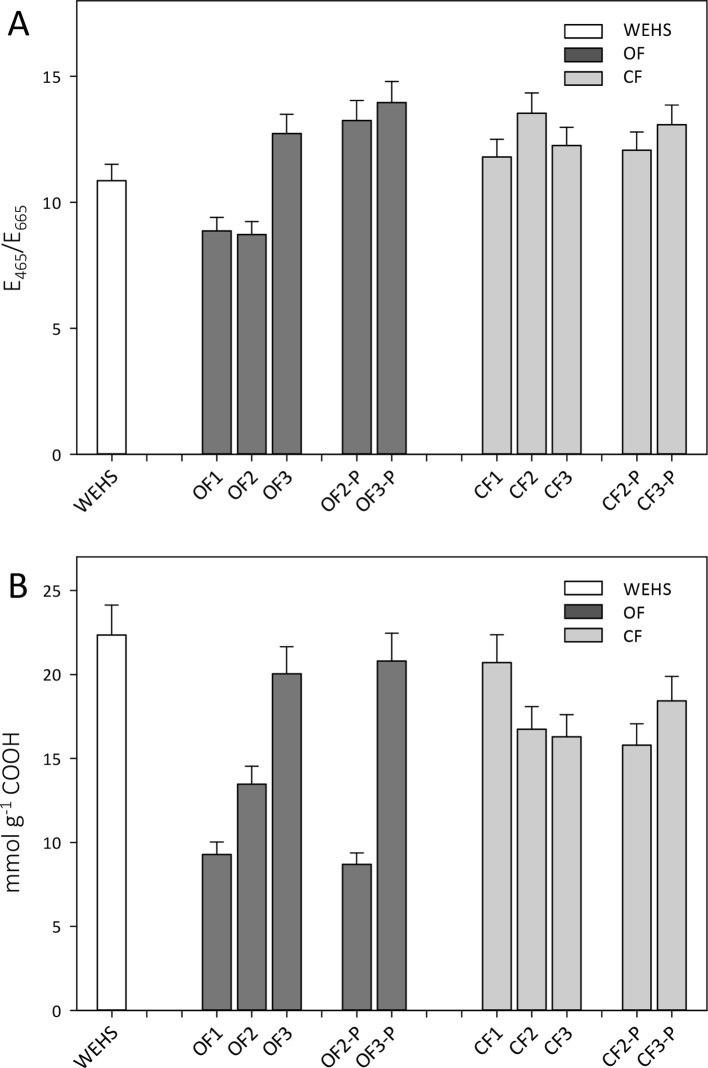
E465/E665 ratios of organic farming (OF) and conventional farming (CF) fractions (A) and density of carboxylic groups in dissolved humic substances (DHS) obtained by titration with NaOH 0.1 M (B). White bar refers to water-extractable humic substances (WEHS); dark gray bars refer to DHS isolated from OF soils; light gray bars refer to DHS isolated from CF soils (data shown are means plus standard deviation). OF1 and CF1 were sampled in November; OF2, OF-P2, CF2, and CF-P2 were sampled in April; OF3, OF-P3, CF3, and CF-P3 were sampled in June. OF1, OF2, OF3 and CF1, CF2, CF3 refer to leachates collected from bare soil columns. OF-P2, OF-P3 and CF-P2, CF-P3 refer to leachates collected from planted soil columns.